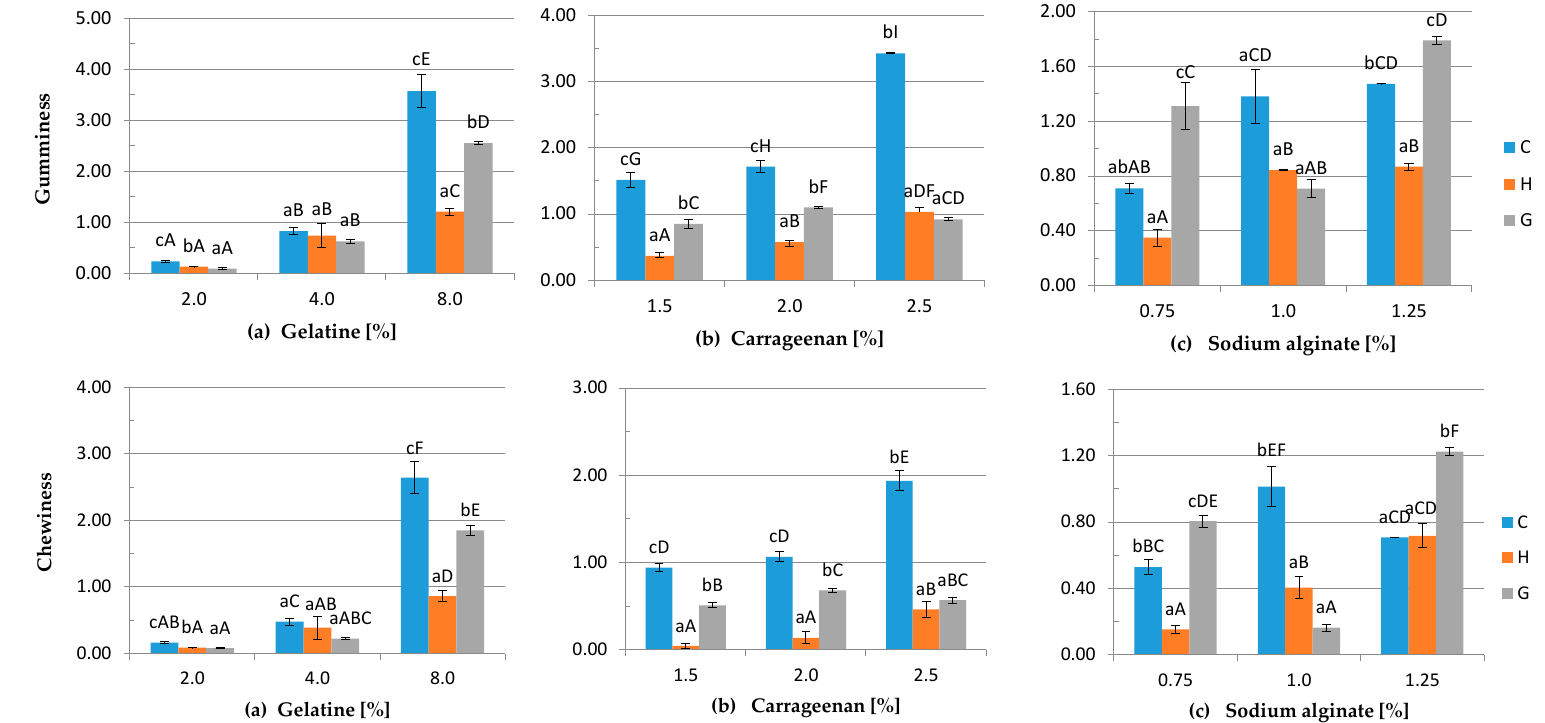
Figure 5. The effects of using DC on the mechanical properties of three variants of the gels: C, H, G (see description in the text) of: ( a ) gelatine, ( b ) carrageenan and ( c ) sodium alginate with different polymer concentrations and the addition of 0.2% ( w / v ) NaCl. Differences between means with the same exponent letter are not significant at a p -level value <0.05. a–c lower case letters indicate differences between means with the same polymer concentration for different DC treatments; A–I capital letters indicate differences between means evaluated with different polymer concentrations and DC treatment.